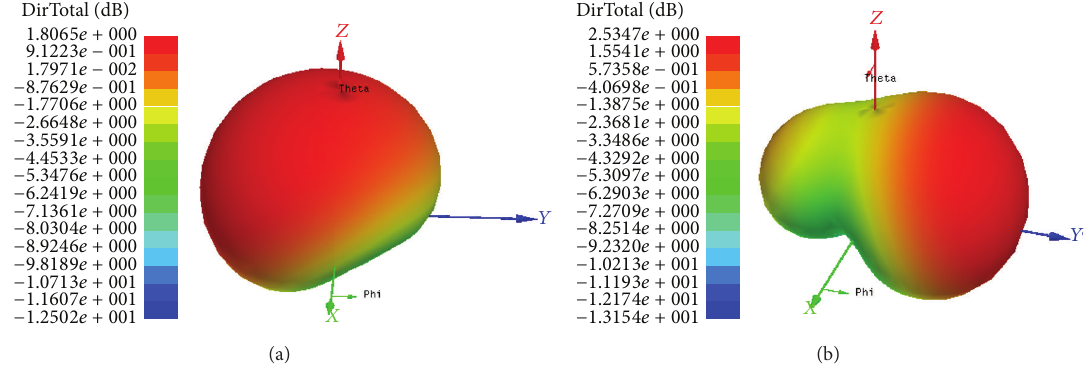
Figure 4: Simulated 3D radiation patterns for the single NFRP element reconfigurable antenna. (a) S1 ON and S2 OFF ( 𝑓 𝑅 = 1.55 GHz), and (b) S1 OFF and S2 ON ( 𝑓 𝑅 = 1.72 GHz).